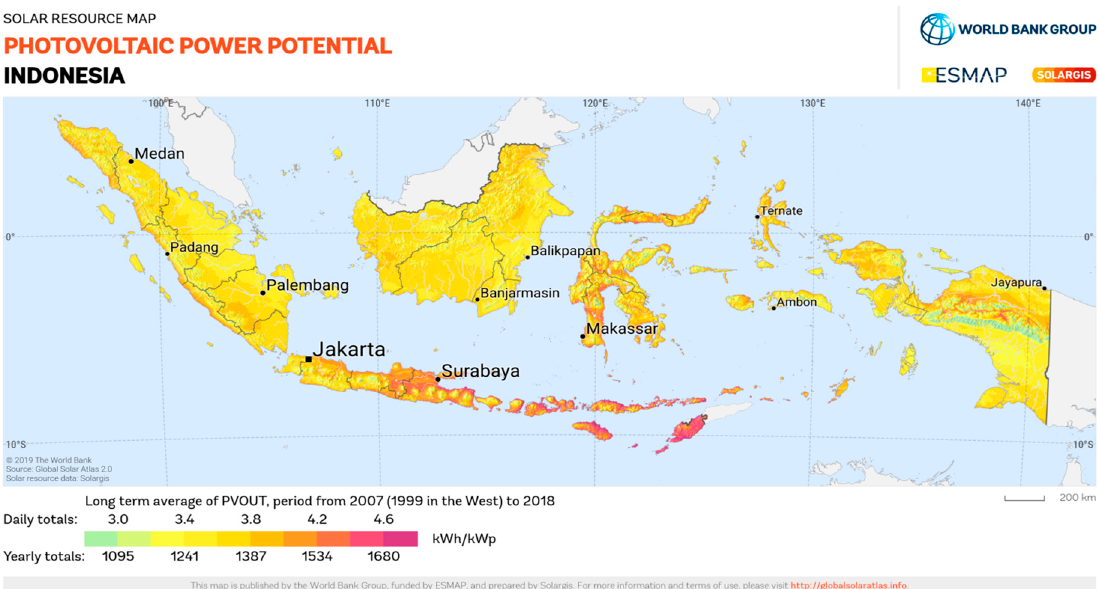
Figure 5. Yearly Global horizontal irradiation in Indonesia [35].